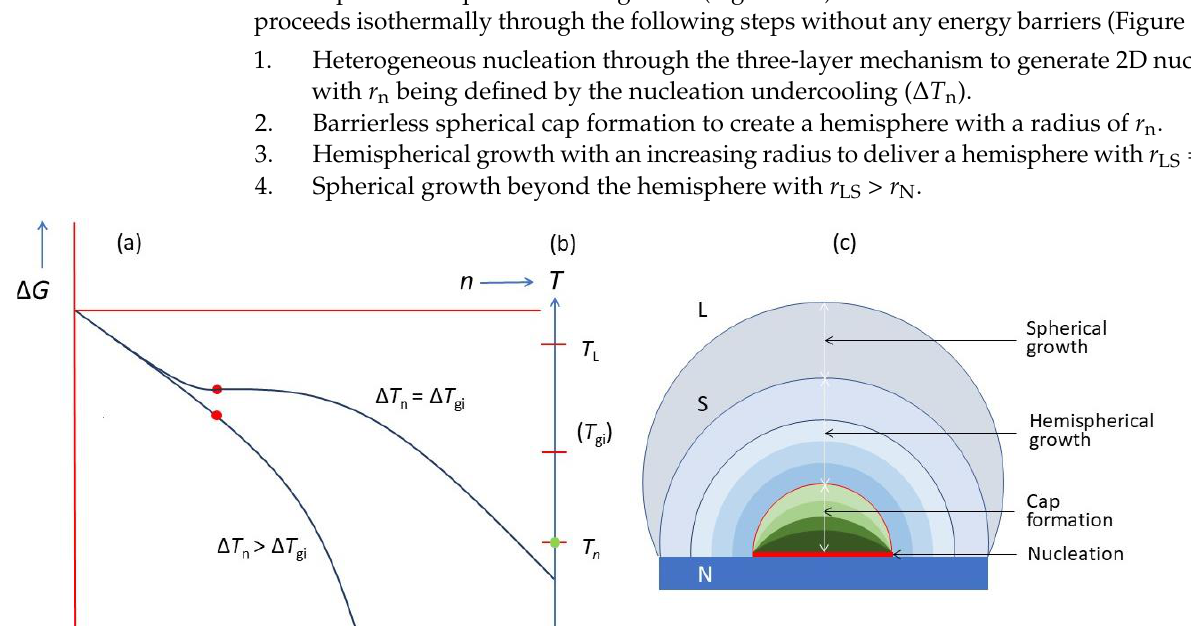
Figure 15. Schematic illustration of the unconstrained cap formation process. ( a ) Free energy change (Δ G ) as a function of number of solid atoms ( n ) at different undercoolings (Δ T ); ( b ) relative position of different temperatures ( T ); and ( c ) the unconstrained cap formation process under isothermal condition. The red dot marks the nucleation finishing point. When Δ T n > Δ T gi , there is no energy barrier for grain initiation.